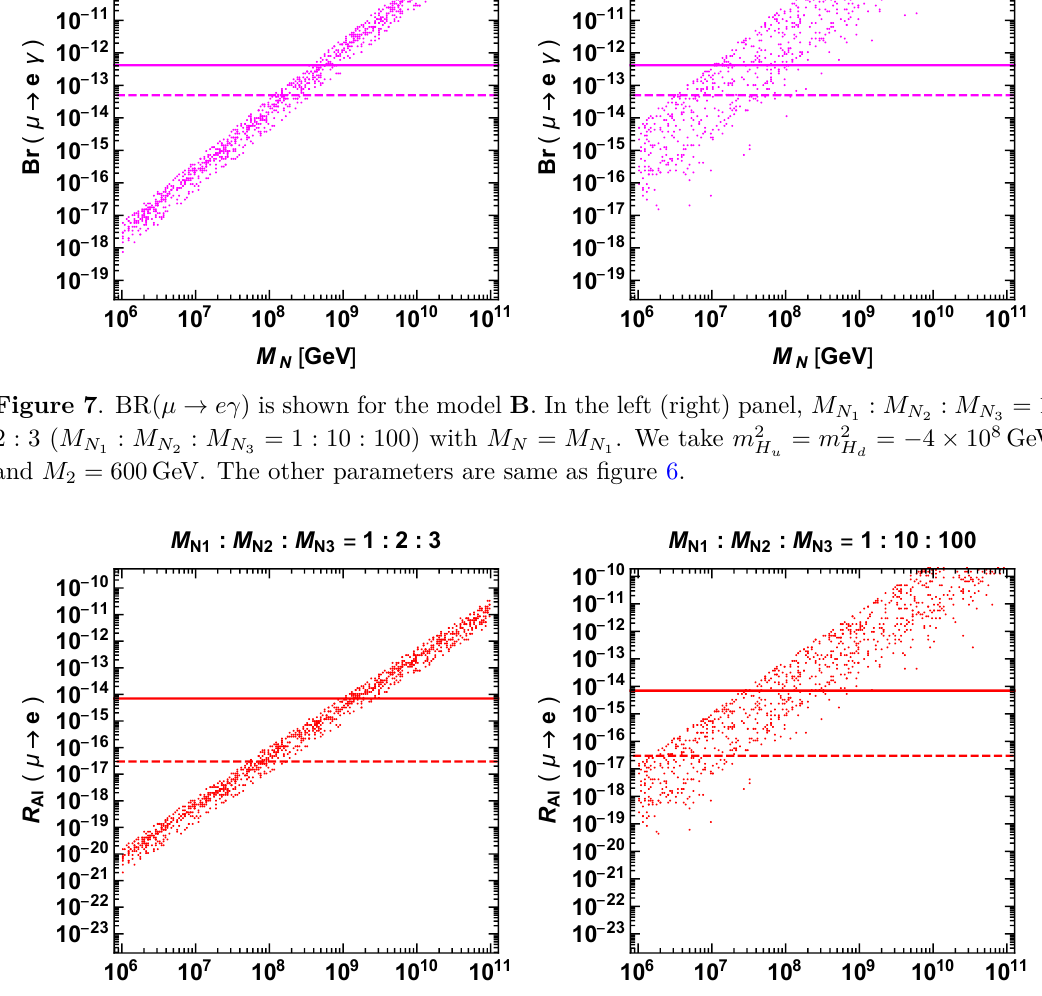
Figure 8 . R Al ( µ → e ) is shown for the model B . The parameters are same as figure 7.